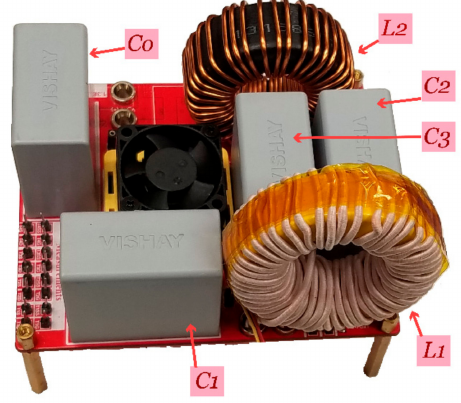
Figure 7. Experimental